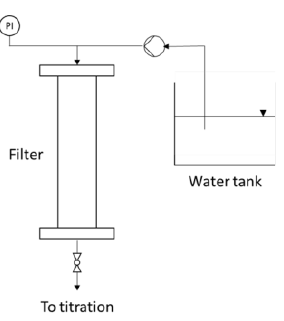
Figure 1. Schematic representation of the experimental setup.